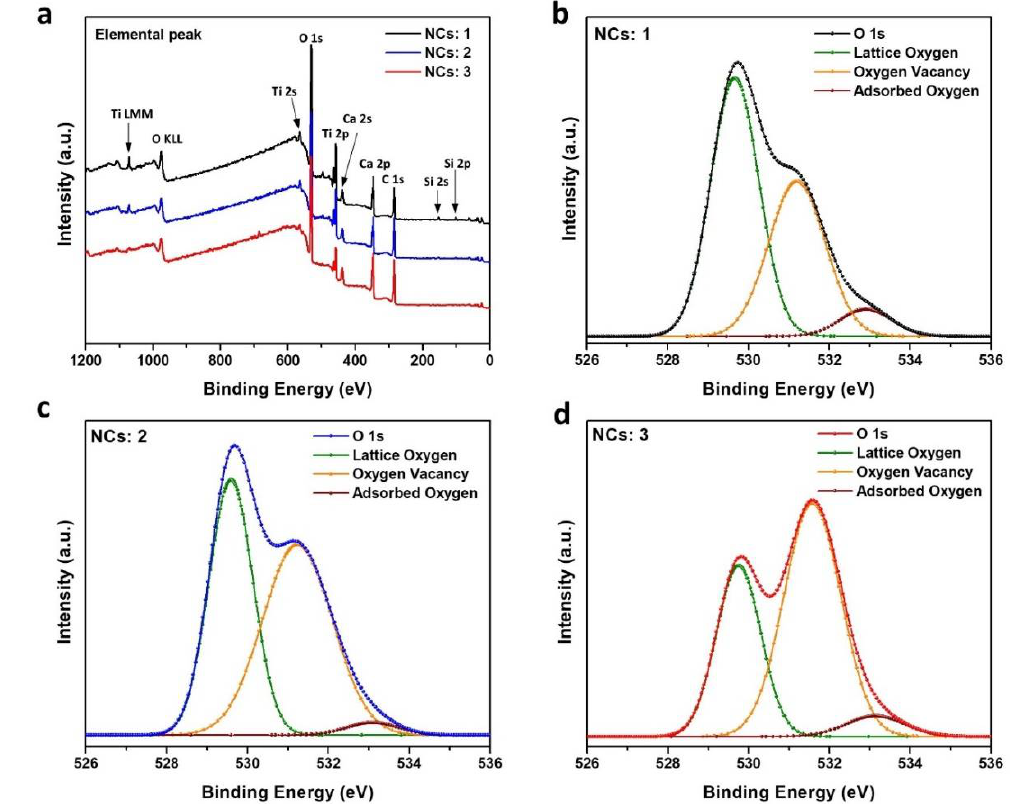
Figure 7. ( a ) XPS photoelectron spectra for three different CTO films. O-1s electronic level of ( b ) NCs: 1, ( c ) NCs: 2, and ( d ) NCs: 3.